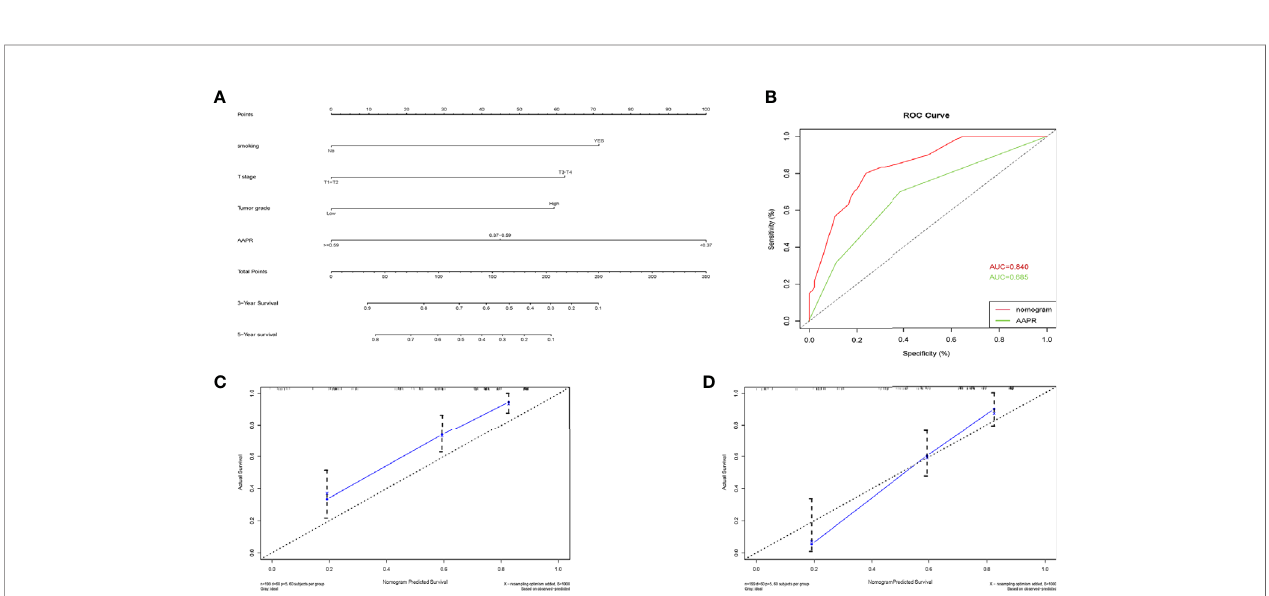
FIGURE 8 | Nomogram model constructed by independent prognostic factors predicting 3- and 5-year RFS for BC patients treated with RC (A) ; the ROC curve of AAPR and AAPR-based nomogram for predicting RFS in the primary cohort (B) ; corresponding calibration curves of nomogram model for 3- and 5- year RFS (C, D) . RFS, recurrence-free survival; AAPR, albumin-to-alkaline phosphatase ratio; BC, bladder cancer; ROC, receiver operating characteristic; AUC, area under curve; CI, con fi dence